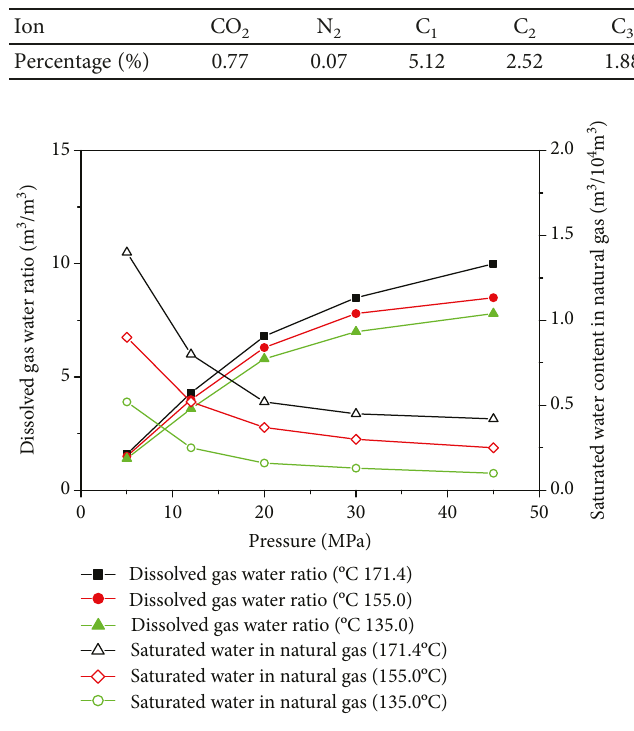
Figure 2: Gas and water dissolved content change curves of BS8 formation fl